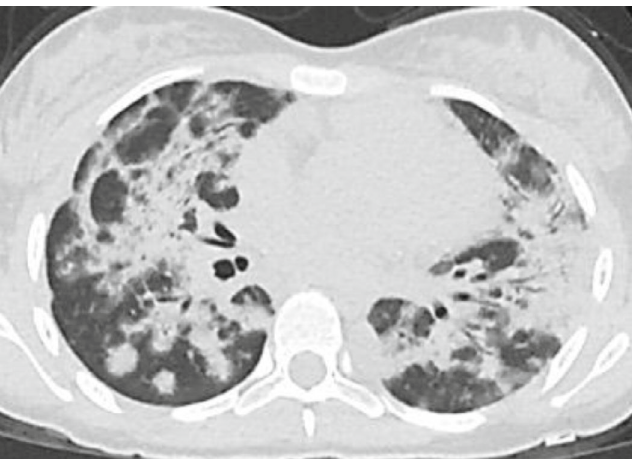
Figure 2: Axial high-resolution CT demonstrates extensive bilateral peribronchovascular consolidations with air bronchograms, as well as scattered small nodular opacities.